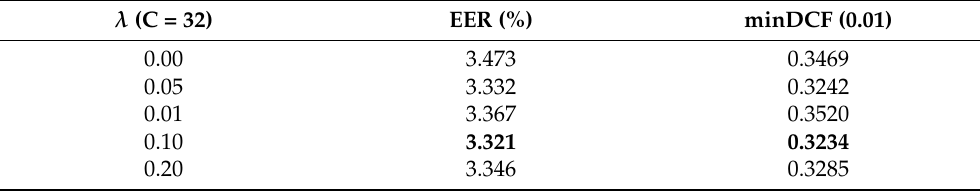
Table 5. Exploration of the effects with different λ on VoxCeleb. (AM-Softmax + λ